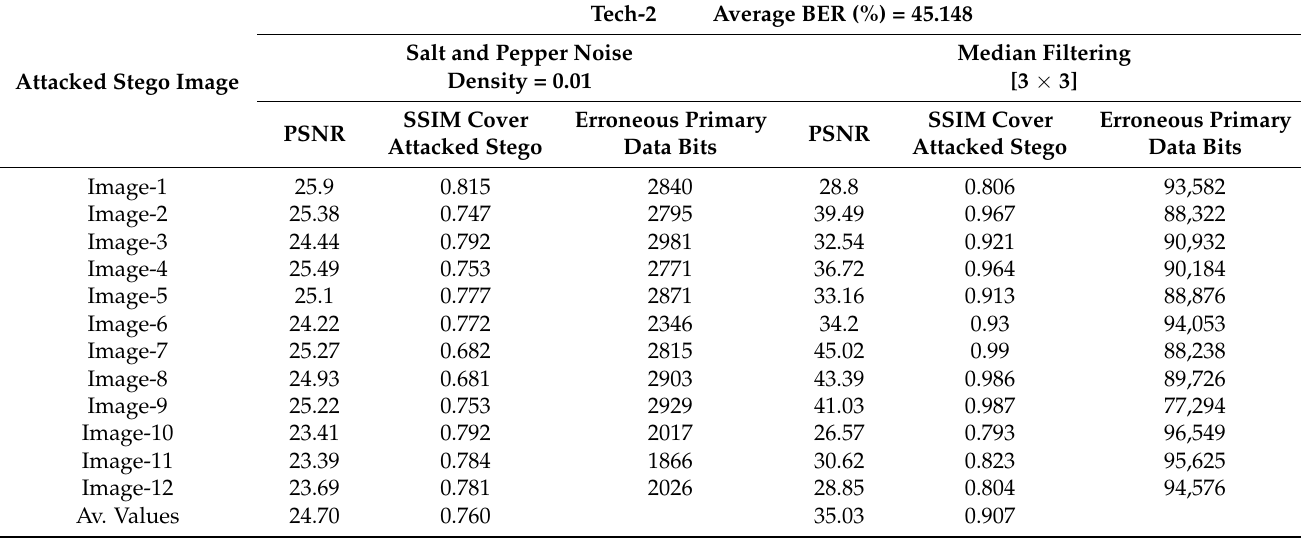
Table 6. Authentication analysis for salt and pepper and median filtering